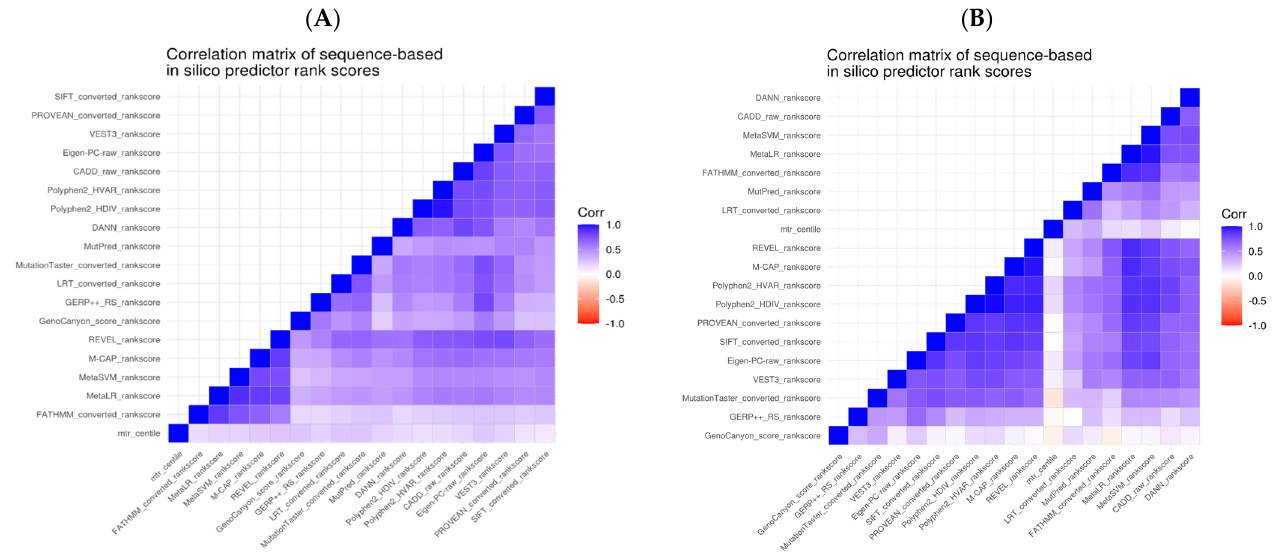
Figure 2. Correlation plot of in silico predictor scores for complete cases of variants. ( A ) Correlation of scores for all Epi4K variants across all genes. ( B ) Correlation of scores for Epi4K variants within the 34 DEE genes.